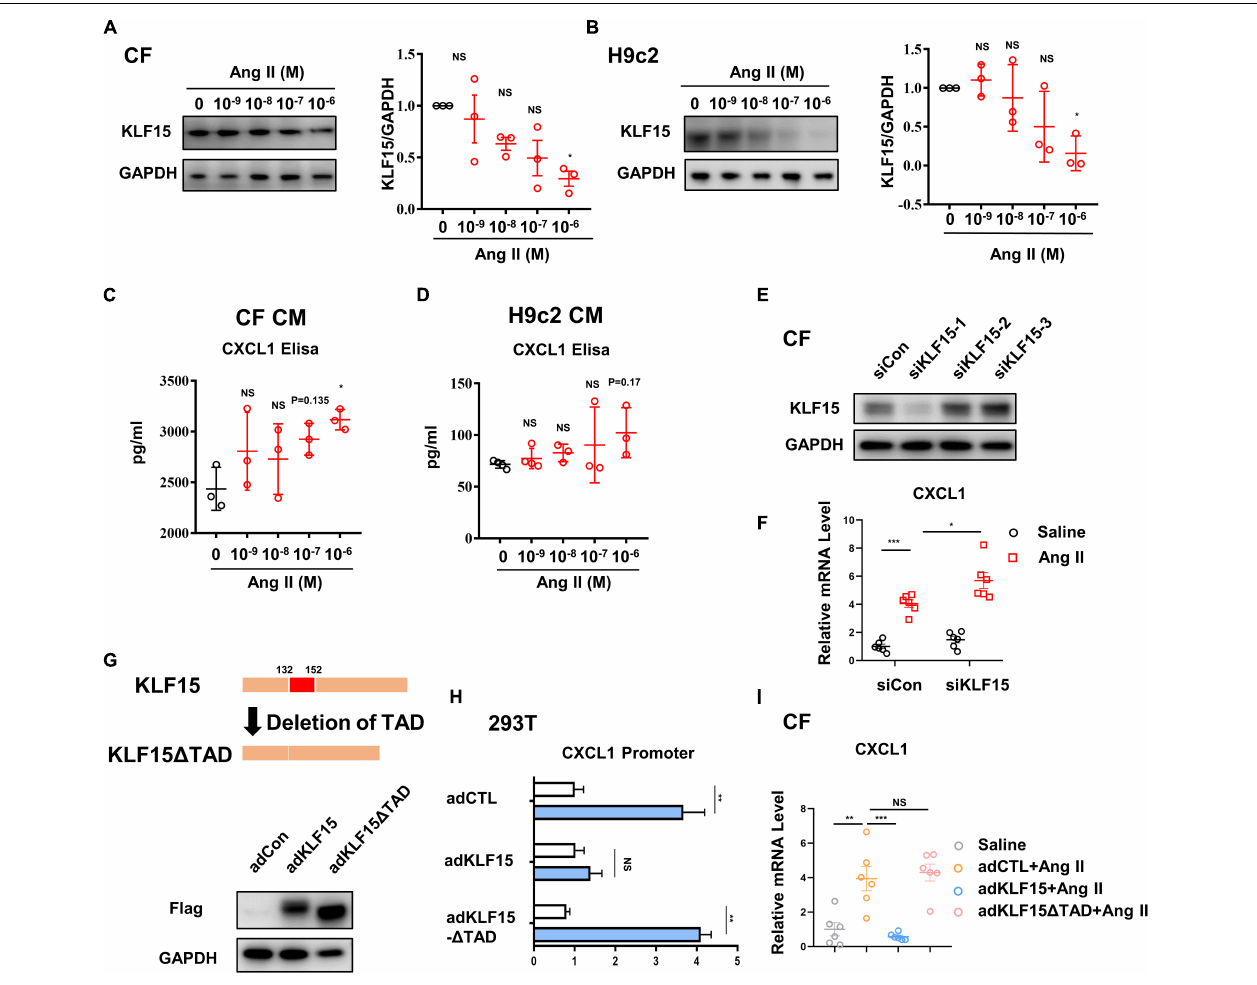
FIGURE 4 | KLF15-TAD negatively regulated CXCL1 transcription in CF. CF and H9c2 cells were stimulated by different doses of Ang II for 24 h. (A,B) KLF15 level was measured and quantified by Western Blot analysis. (C,D) The CXCL1 protein in cell supernatant of Ang II treated CF and H9c2 cells was detected by an Elisa assay. (E) CF cells were transfected with con-siRNA and KLF15-siRNA. Successful knockout of KLF15 by KLF15-siRNA was confirmed by Western Blot. (F) CXCL1 mRNA levels of Ang II-treated WT CF and KLF15 knockdown CF were measured by qPCR. (G) Adenovirus-mediated overexpression of KLF15 and deletion of transactivation domain (TAD) of KFL15 were verified by Western Blot. (H) Luciferase assay was used to detect CXCL1 promoter activity in AdCTL, AdKLF15, and AdKLF15- (cid:49) TAD-infected CFs. (I) CXCL1 mRNA levels of AdCTL, AdKLF15, and AdKLF15- (cid:49) TAD infected CFs were measured and analyzed by qPCR. * P < 0.05, ** P < 0.01, and *** P <